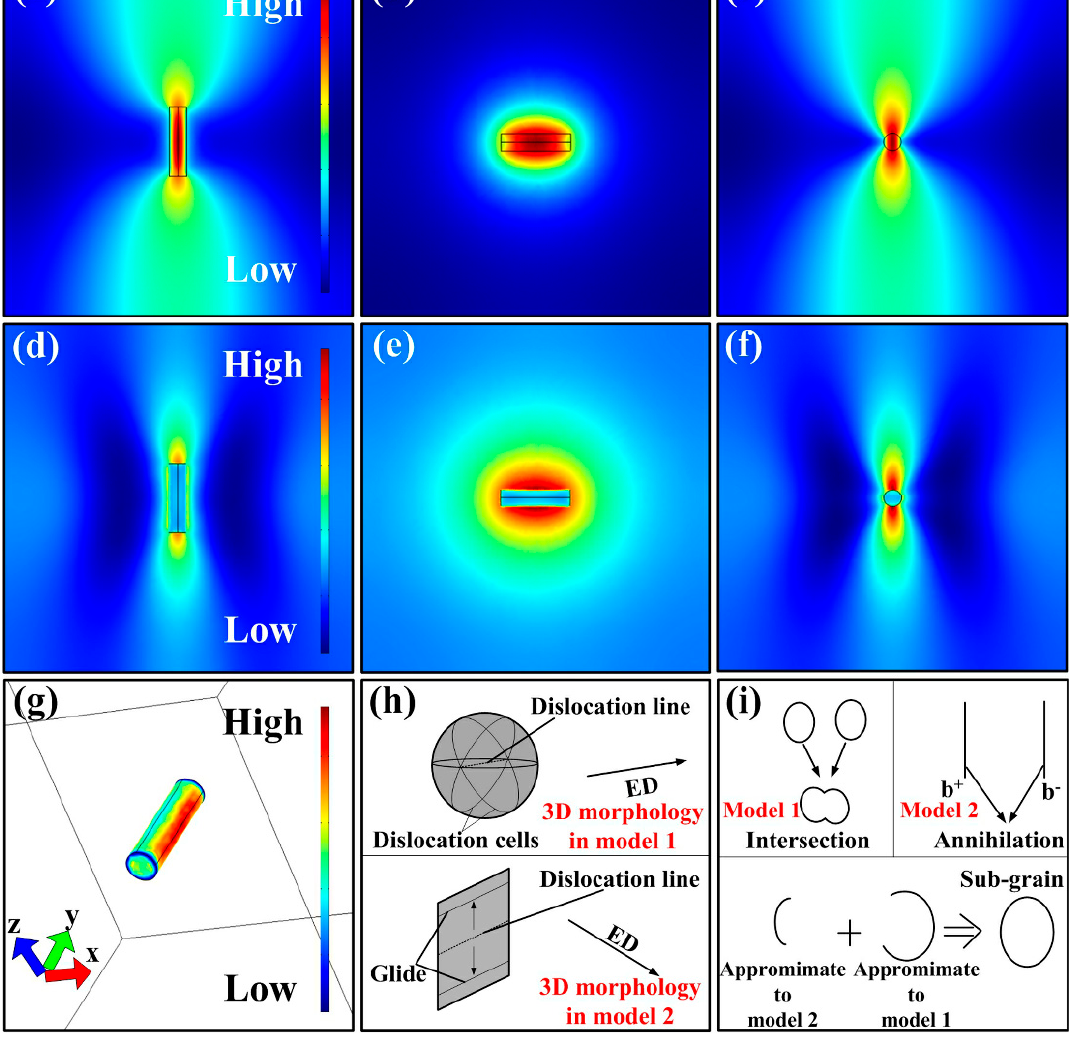
Figure 9. Simulation results of model 2: ( a – c ) Distribution of temperature at XY, YZ, and XZ plane; ( d – f ) distribution of current density at XY, YZ, and XZ plane; ( g ) distribution of thermal stress; ( h ) reveals the dislocation morphology after current was applied; ( i ) reflects dislocation motion in model 1, model 2, and the actual situation.